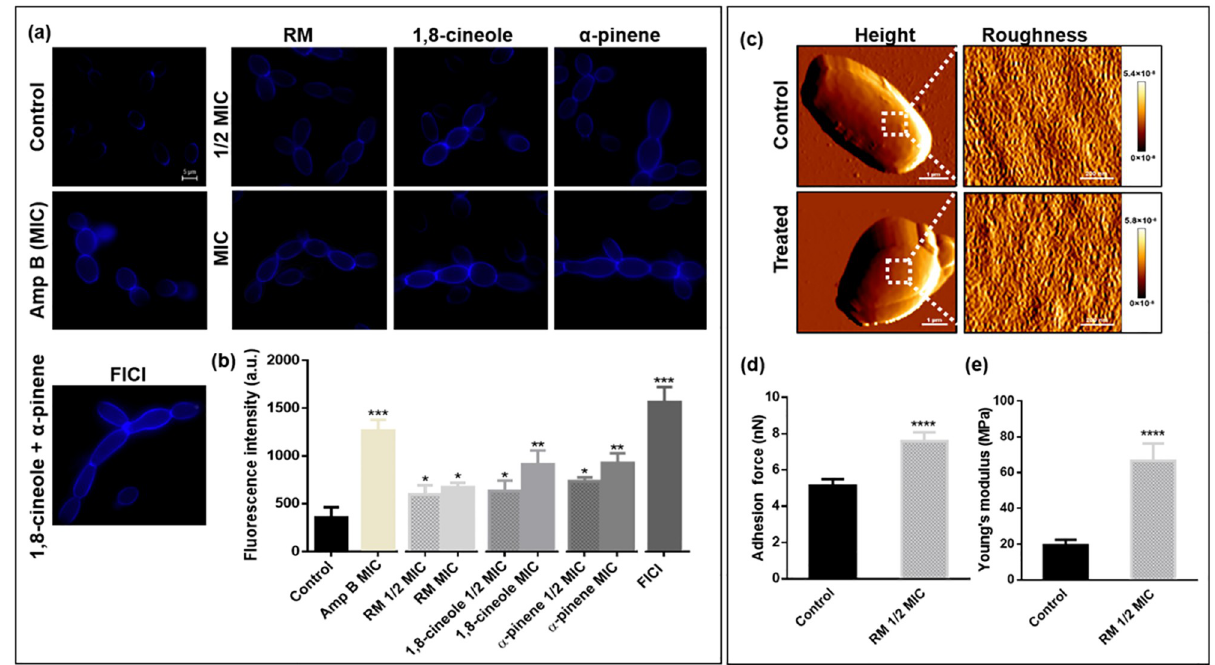
Fig 2. Effects of RM oil, 1,8-cineole, and α -pinene on C . albicans RSY150 cell separation, chitin production and surface remodelling. (a) Representative epifluorescence images of C . albicans with our without exposure to oils for 4h, followed by calcofluor white staining. Cells in media served as a negative control. Scale bar for the control is 5 μ m and represents the scale for all images. (b) Bar graphs of total fluorescence intensity. AFM QI ™ data for control and RM oil treated C . albicans at (c, left) low (10 μ m, 128 × 128 pixel) (c, right) and high (1 μ m, 128 × 128 pixel) resolution was used to generate representative topographic images of the cell surface (boxed area images), revealing no change in surface roughness (visually and quantitatively), but the data indicate a significant increase in (d) adhesion and (e) elasticity for treated cells. Data are presented as the mean ± SEM of three biological replicates, with (b) 300 representative cells per replicate, or (d and e) 17 cells per replicate, for which statistical significance ( ���� , p < 0.0001; ��� , p < 0.001; �� , p < 0.01; � , p < 0.05) was analysed by an unpaired Student’s t -test of treated compared to